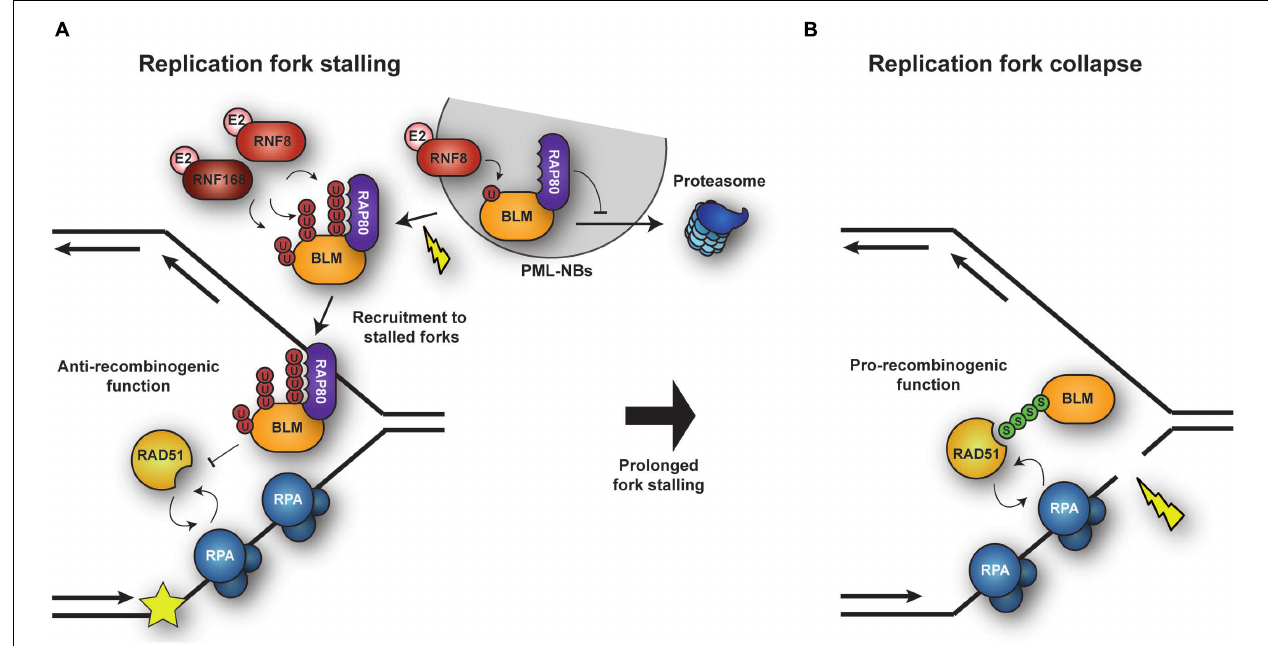
FIGURE 4 | Regulation of BLM activity under conditions of replicative stress. (A) Upon replication fork stalling, BLM is polyubiquitylated by the ubiquitn E3s RNF8 and RNF168. Polyubiquitylated BLM is recognized by RAP80, which mediates relocation of BLM from PML nuclear bodies and recruitment to stalled forks. At the fork BLM suppresses unwanted HR events. (B) Upon collapse of a stalled fork, BLM is SUMOylated, thereby facilitating the recruitment of RAD51 and repair by